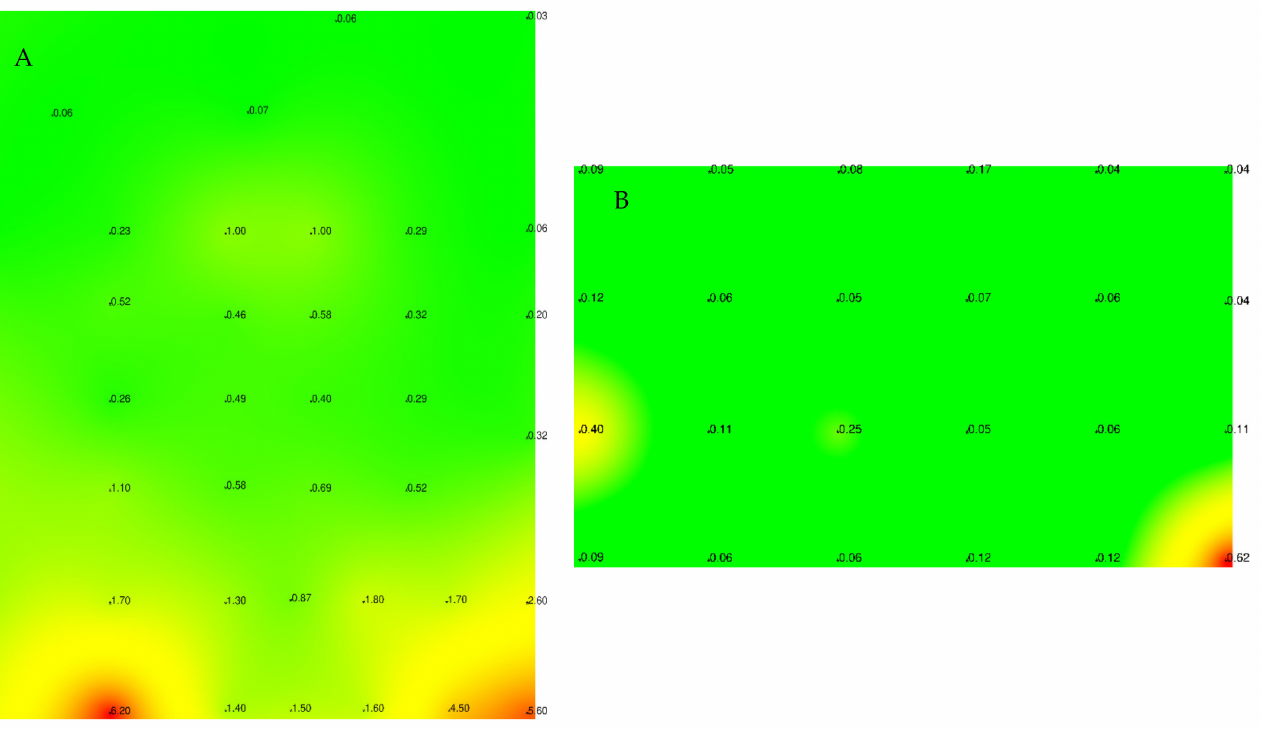
Figure 5. Radiation maps of rooms “ A ” and “ B ”.